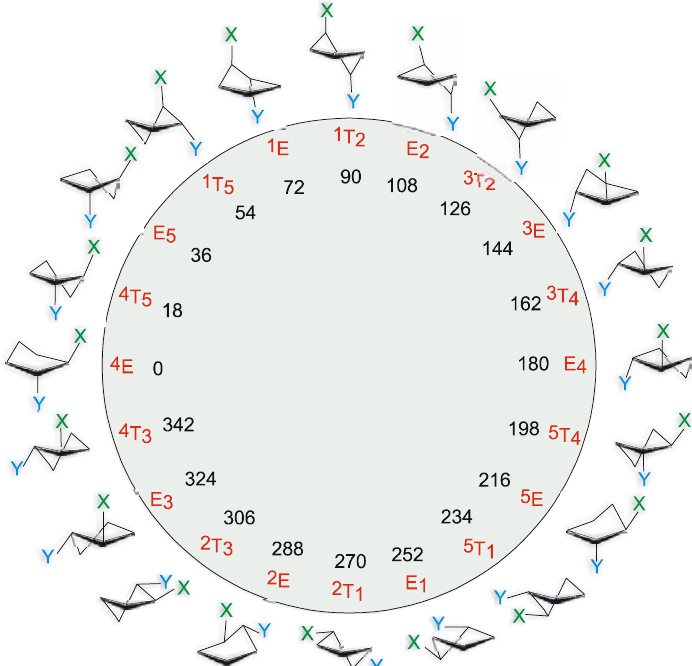
Figure 1. Pseudorotation in disubstituted cyclopentanes. Numbers in black inside the circle are values of the phase angle of pseudorotation, numbers and letters in red are the names of the basis